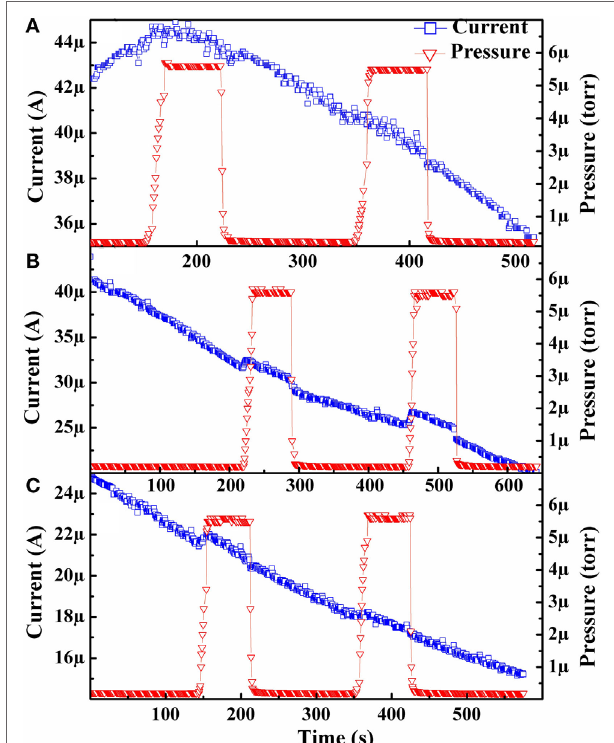
FigUre 1 | Isothermal emission current behavior of an as-grown diamond cathode in both vacuum and low-pressure hydrogen environment at: (a) 600°C, (B) 625°C, and (c) 650°C. Only the first testing cycle for the as-grown sample is presented for publication purposes as a similar trend was seen for each test in the following two testing cycles. The current and pressure data are represented by blue squares and orange triangles,